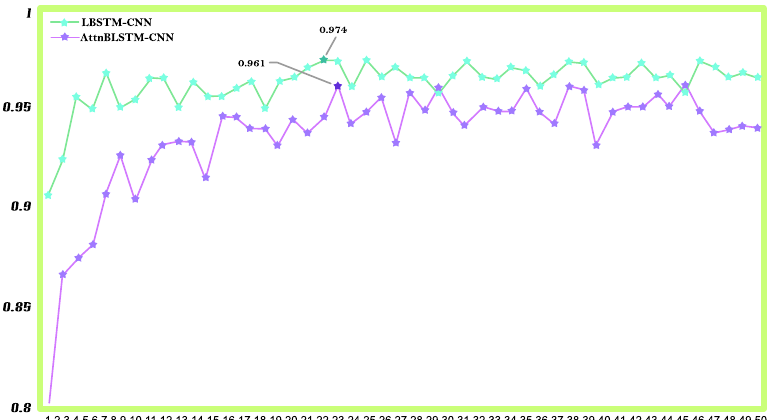
Figure 11. Results of 50 iterations of AttnBiLSTM-CNN and BiLSTM-CNN check-all